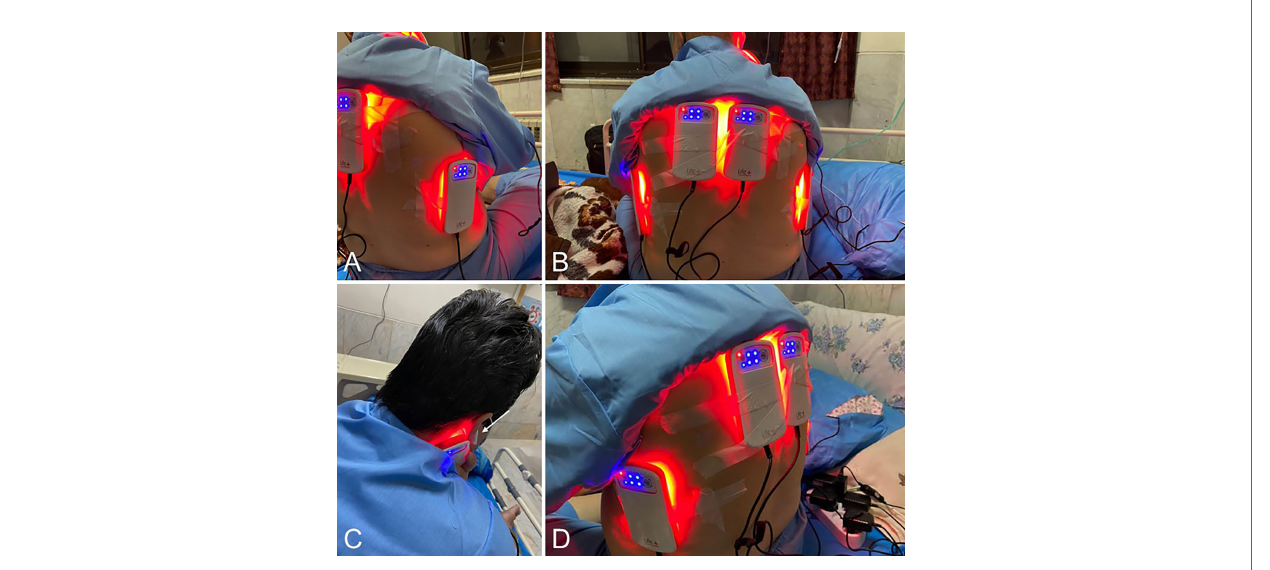
FIGURE 1 | Illustrations of the positioning of the Photobiomodulation devices on the patients. (A, D) , 3/4 back view. (B) , Back view. (C) , View of the device positioned at the carotid artery; the white arrow shows the patient ’ s sound isolation device for